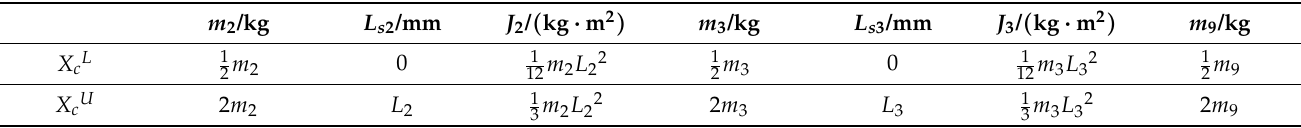
Table 1. Value ranges of X cU and X cL